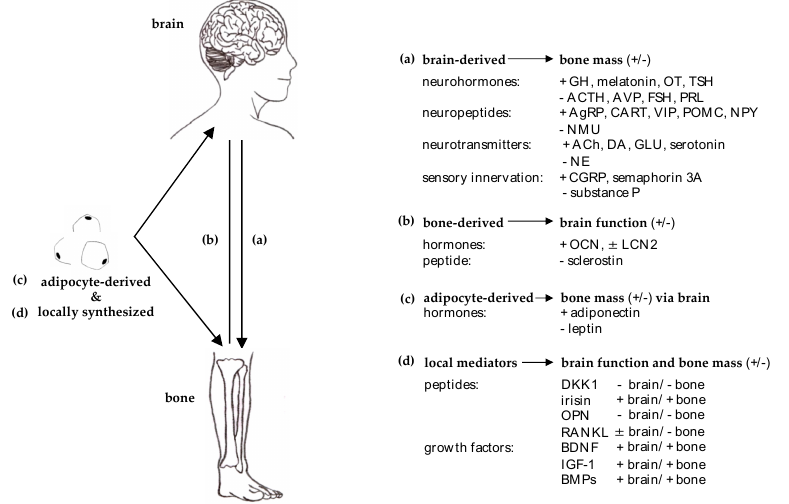
Figure 1. Molecular bases of brain and bone crosstalk. Summary of the predominant mediator e ff ect of ( a ) brain-derived on bone, ( b ) bone-derived on brain, ( c ) adipocyte-derived on bone via central modulation and ( d ) locally synthesized mediators a ff ecting brain and bone concurrently. The mediator e ff ect on brain function and bone mass previously reported was summarized as positive ( + ) and negative ( − ). Abbreviations: ACh =